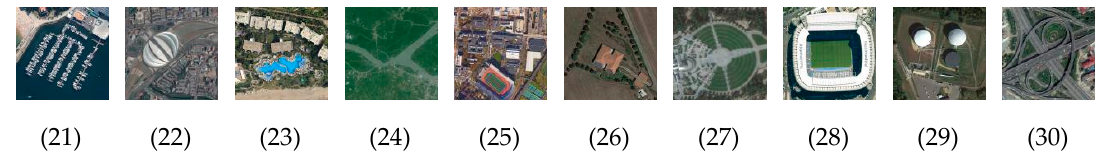
Figure 3. Example images of AID dataset: (1) airport; (2) bare land; (3) baseball field; (4) beach; (5) bridge; (6) centre; (7) church; (8) commercial; (9) dense residential; (10) desert; (11) farmland; (12) forest; (13) industrial; (14) meadow; (15) medium residential; (16) mountain; (17) park; (18) parking; (19) playground; (20) pond; (21) port; (22) railway station; (23) resort; (24) river; (25) school; (26) sparse residential; (27) square; (28) stadium; (29) storage tanks; and (30) viaduct. NWPU ‐ RESISC45 dataset is more complex than UC Merced Land ‐ Use and AID datasets and